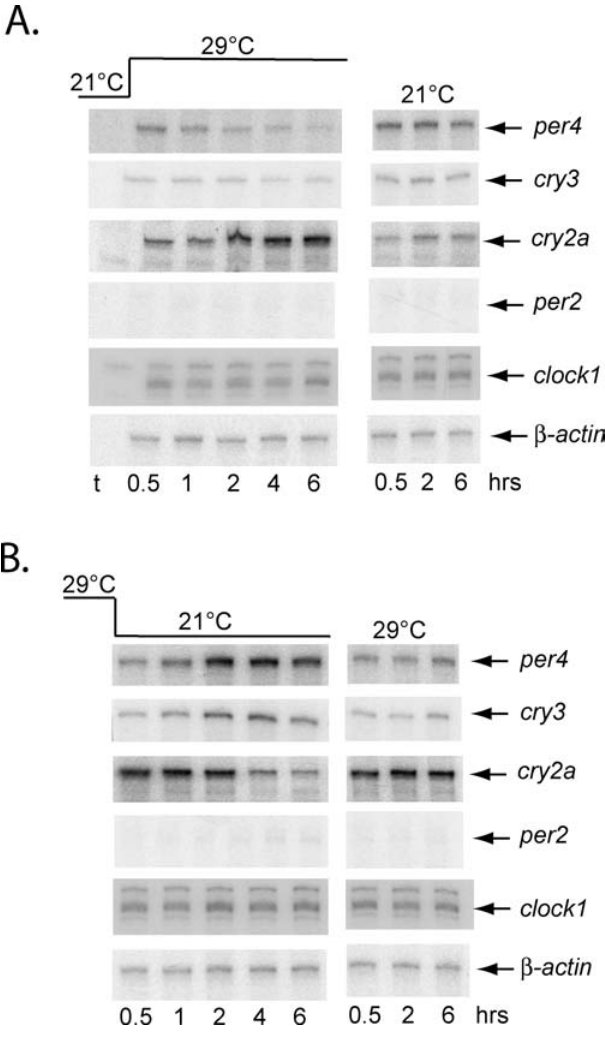
Figure 3. Temperature Steps Regulate Clock Gene Expression Levels (A) Larvae were raised in DD at 21 8 C for 7 d and then shifted to 29 8 C and harvested at the indicated times relative to the temperature shift (h). Controls remained at 21 8 C and were harvested in parallel with the temperature shift larvae. RPA analysis of the indicated genes was then performed. ‘‘ t ’’ represents a tRNA control sample. (B) As in (A), except that 5-d-old larvae were shifted from 29 8 C to 21 8 C, and controls remained at 29 8 C. All data are representative of at least three independent experiments. DOI: